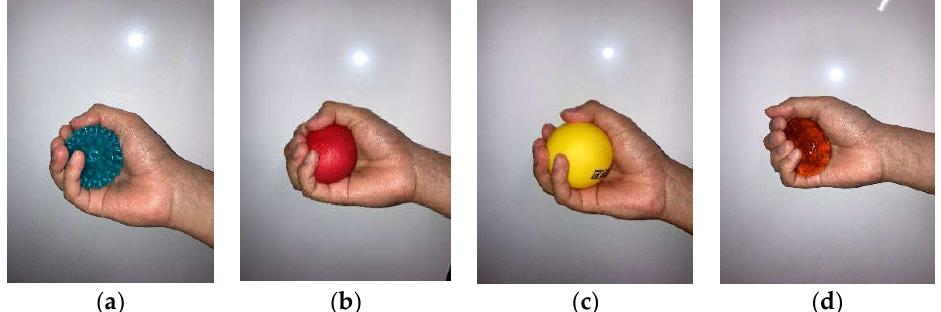
Figure 1. Pictures of the objects. ( a ) Object 1: A ball with wards; ( b ) Object 2: A squeezable ball; ( c ) Object 3: A regular hard ball; ( d ) Object 4: Slime.